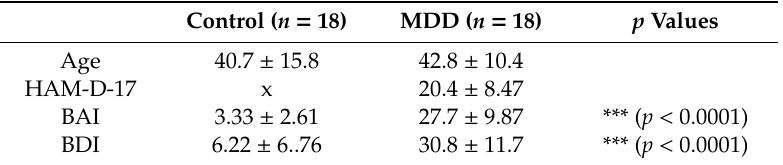
Table 1. Study population demographics.